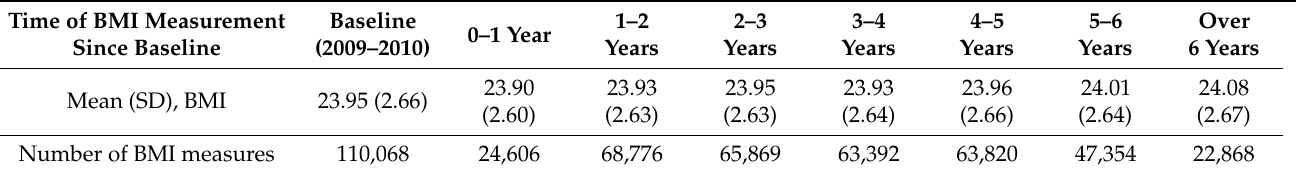
Table 1. Serial measurement of body mass